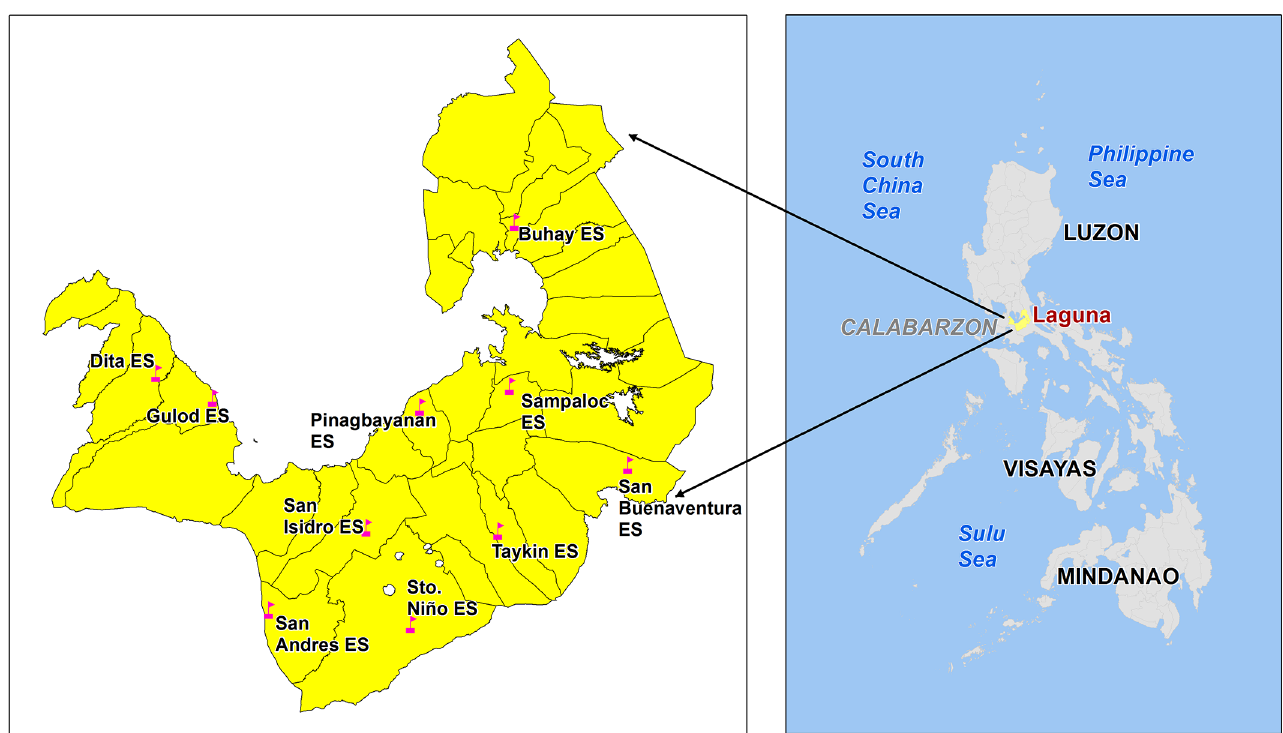
Fig 1. Map of the Philippines showing the location of the elementary school study sites in Laguna province. Map generatedthrough ArcGIS 10.4 software and obtainedfrom the NationalMappingand Resource Information Authority (NAMRIA), Philippines. NOTE: the geospatiallayers (i.e., IndicativeMunicipalBoundaryby PhilippineStatistical Authority) and the locationof schools by Department of Education which were used to generate the map for this study was obtainedfrom the NationalMappingand ResourceInformation Authority (NAMRIA) through the Philippine Geoportal. This data was in a shapefileformat and can be accessedthrough the http://www.geoportal.gov.ph.